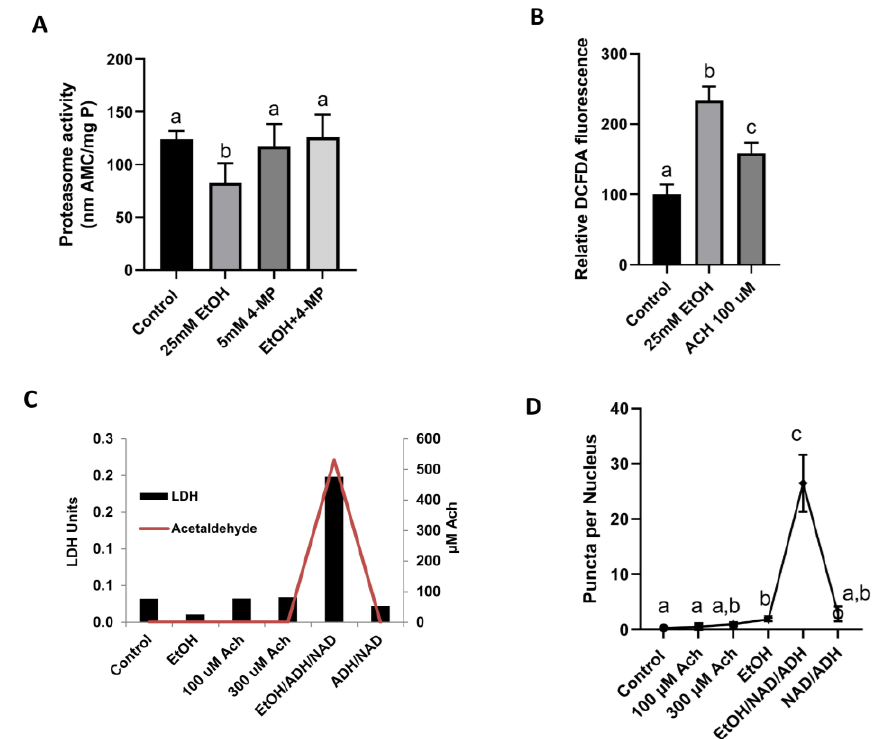
Figure 3. ( A ) Proteasome activity in VL-17A cells treated with 25 mM ethanol for 24 h in the presence and absence of 5 mM 4-methyl pyrazole (4-MP). ( B ) DCFDA fluorescence in VL-17A cell treated with 25 mM ethanol or 100 μM acetaldehyde for 30 min. ( C ) Cellular necrosis (LDH leakage) and Ach levels in HepG2 cells exposed 12 h to the indicated treatments on the x -axis. ( D ) aggresome puncta numbers in HepG2 cells exposed to the indicated treatments. Letter symbols mean the same as in Figures 1 and 2. N = 5–10 microscope fields per group.